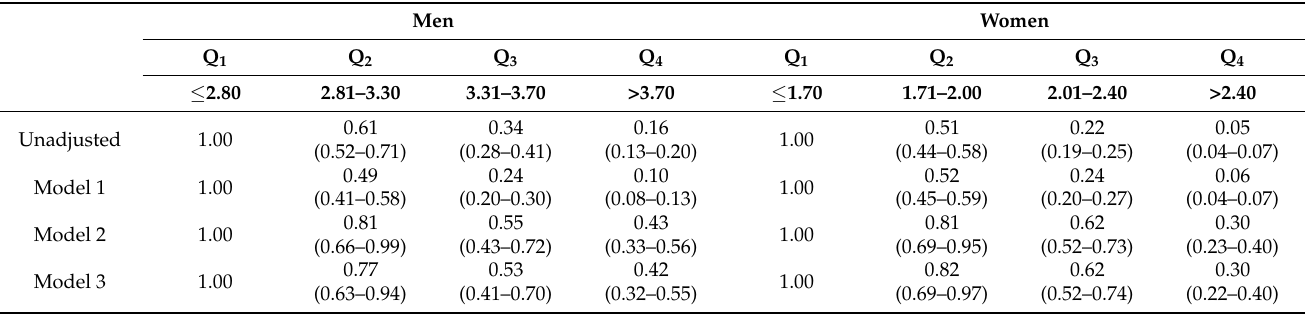
Table 3. Odds ratio and 95% confidence intervals for NAFLD according to RGS in Koreans with the use of